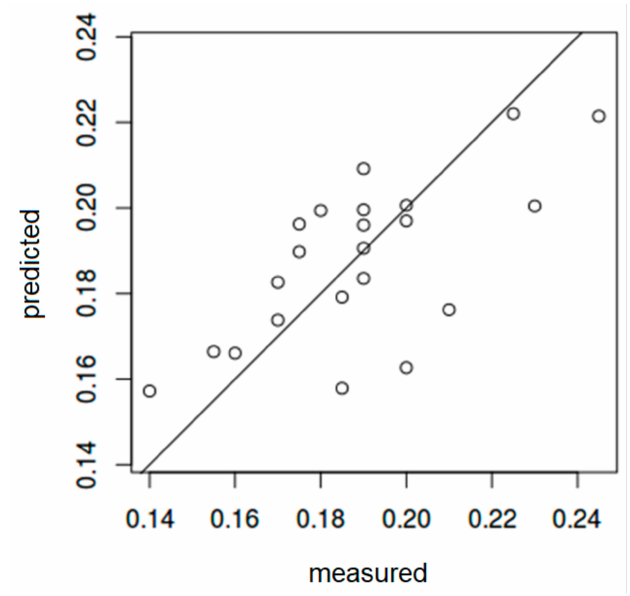
Figure 6. Model prediction of N-absorbance using six components.